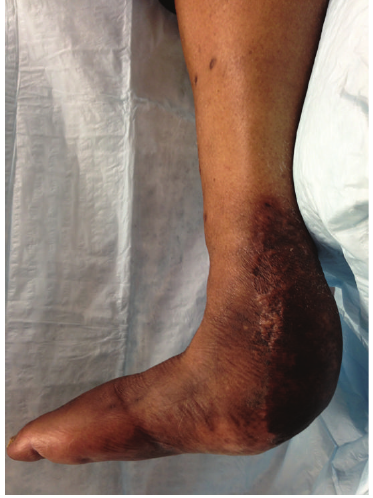
Figure 2: Category 2 partial calcanectomy.